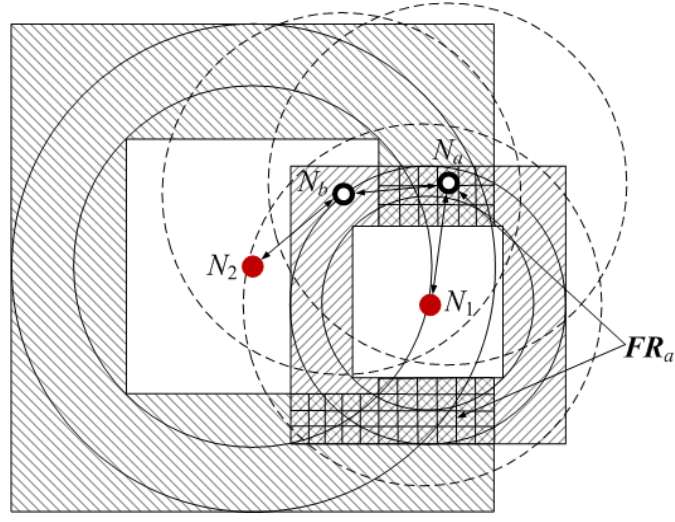
Figure 8. Intersection of bounding square